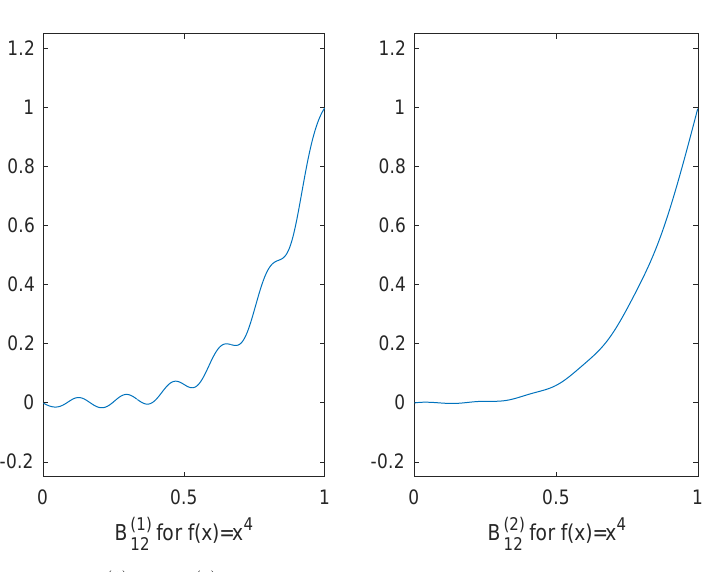
( 1 ) ( 2 ) ( x ) = x 4 and n = 12. Figure 3. B n and B n for f 2. The Extension of Berrut’s First Interpolant to Equally Spaced Points on a